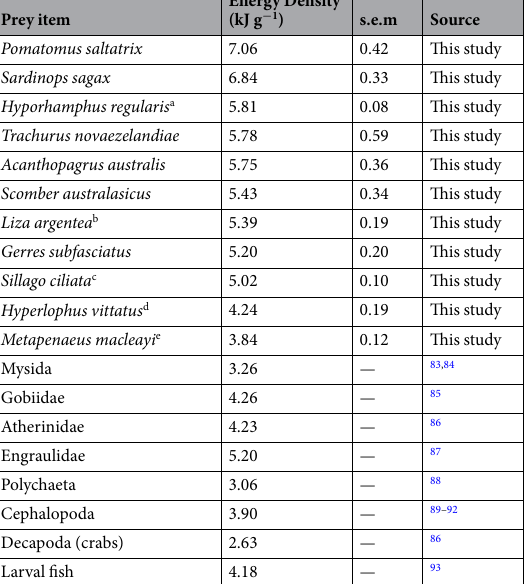
— 1 Derived from Hartman and Brandt 5